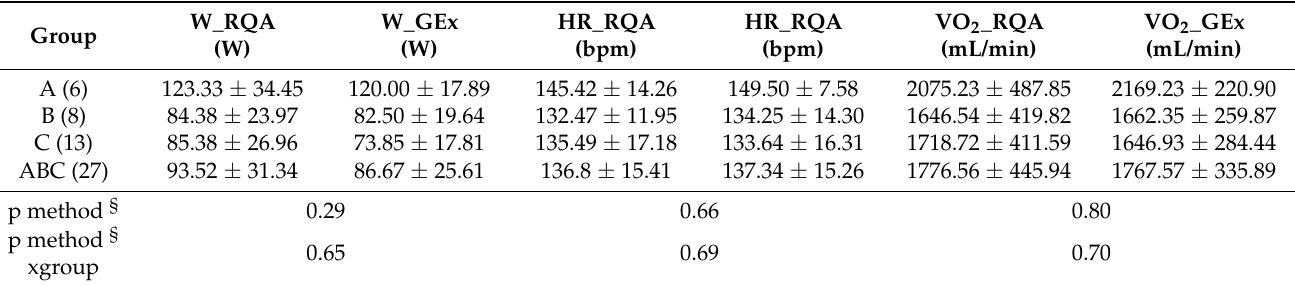
Table 5. Workload, HR, and VO 2 at AerT automatically detected by RQA-method in